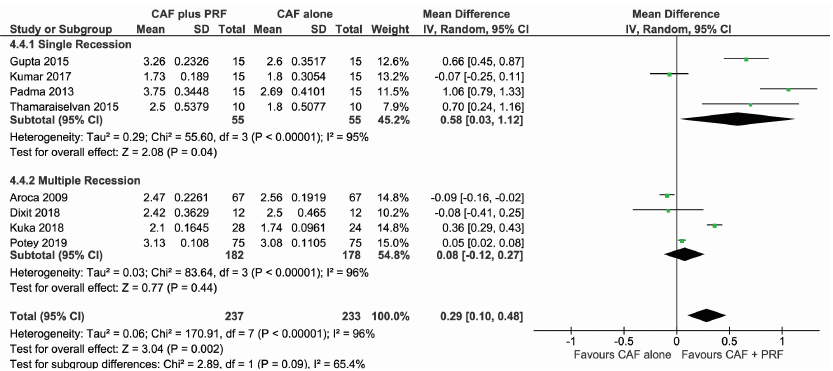
Figure 5. Comparison of change in clinical attachment level (CAL) between CAF + L-PRF versus CAF alone with 6–12 months follow-up.